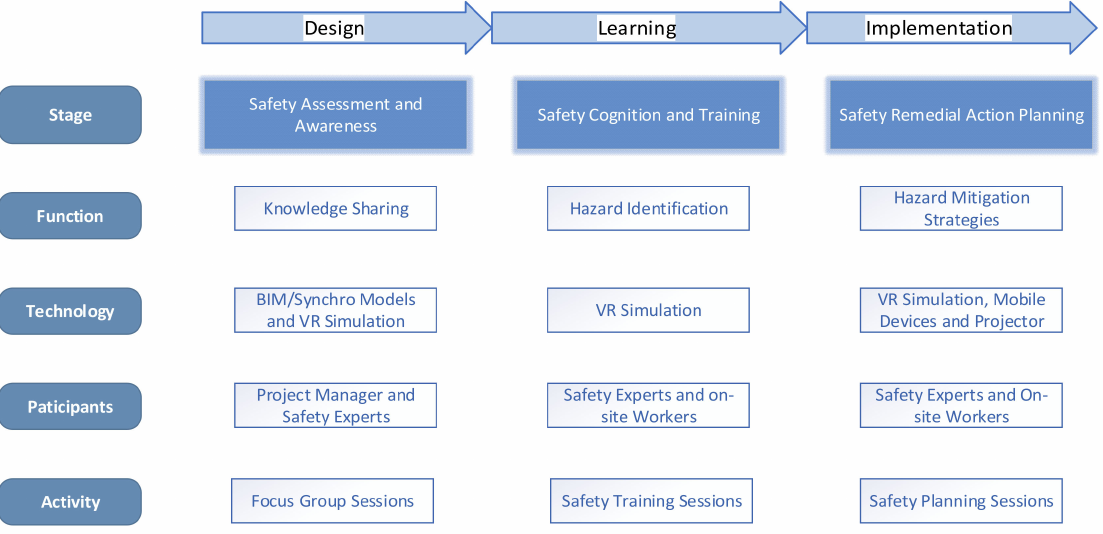
Figure 3. Safety planning and training module used in the case